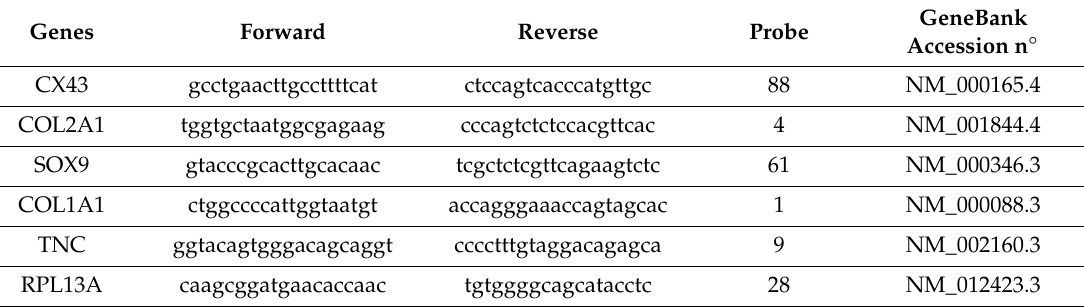
Table 1. Custom made primers.